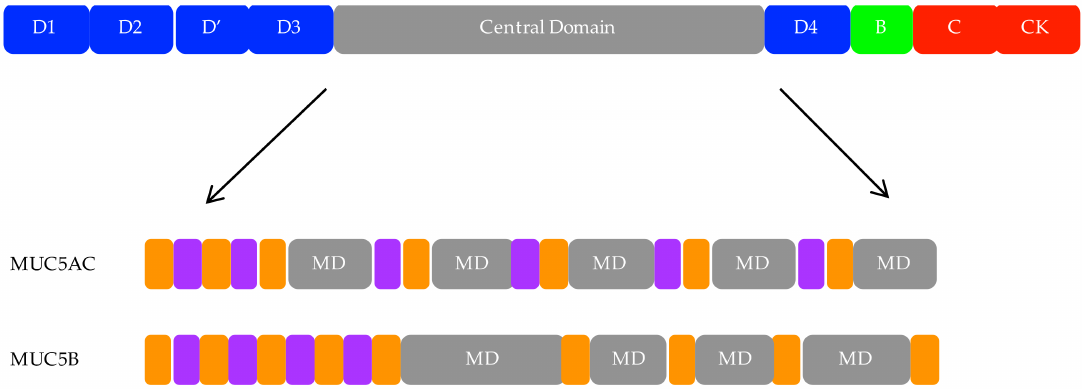
Figure 1. Multidomain structure of the mucins 5AC and 5B (MUC5AC and MUC5B). Top: generic representation of a polymeric mucin. Secreted polymeric mucins possess cysteine-rich vWf-like amino (D1, D2, D’, and D3) and carboxy (D4, B, C, and CK) terminal domains, important for dimerization and polymerization of polymeric mucins, as well as a large, central domain. Bottom: Central domain organization of MUC5AC and MUC5B. The hallmark of the MUC family members are the mucin domains (MDs). These domains are unique in sequence and size, and vary in length and number between different mucins including MUC5AC and MUC5B. They are rich in serine, threonine, and proline, and are the site of O -glycosylation. Additionally, the central region contains repetitive (grey), non-repetitive (purple), and cysteine-rich (orange)